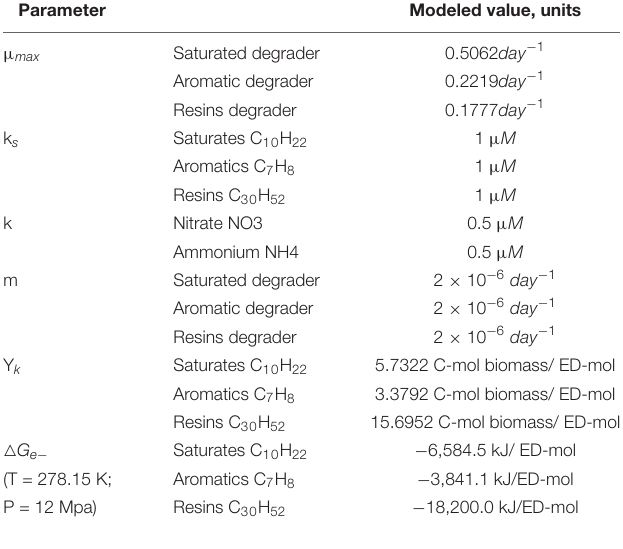
TABLE 4 | Coefficients for the biochemical